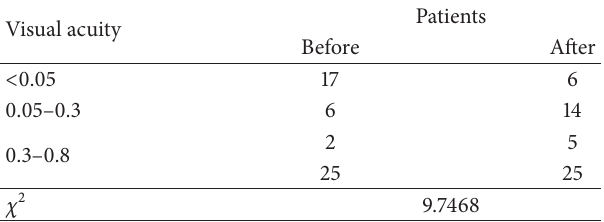
Table 1: The comparison of BSCVA before and after the operation. Visual acuity